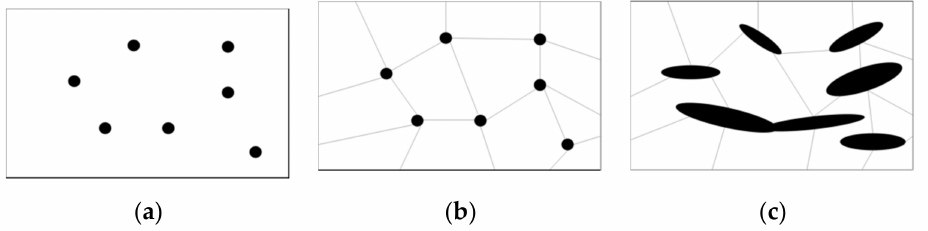
Figure 1. ( a ) Random distribution of the microparticles in the matrix, ( b ) location of the microparticles in boundary grains intersections, and ( c ) variability of microparticle size and shape.